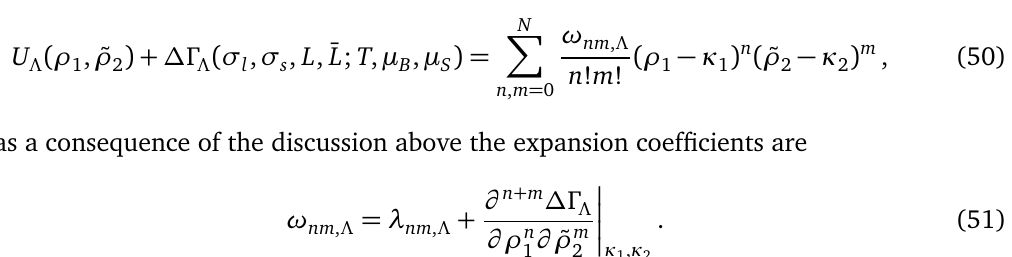
Figure 1: The pressure p , the trace anomaly I and the speed of sound squared c 2 µ = µ = 0 in comparison to lattice results. The temperature has been rescaled to B S t ≡ ( T − T χ ) / T χ du to different pseudocritical temperatures in our model and on the lattice. The HotQCD collaboration data is from [ 92 ] and the Wuppertal-Budapest collaboration (WB) data from [ 93 ]